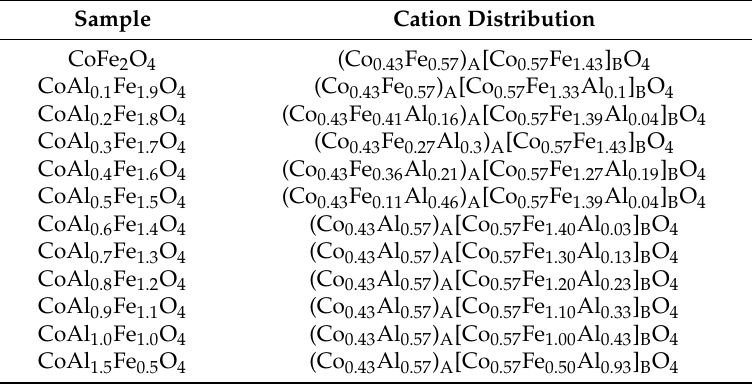
Table 4. The cationic distribution of all samples, which were calcined at 1000 ◦ C.